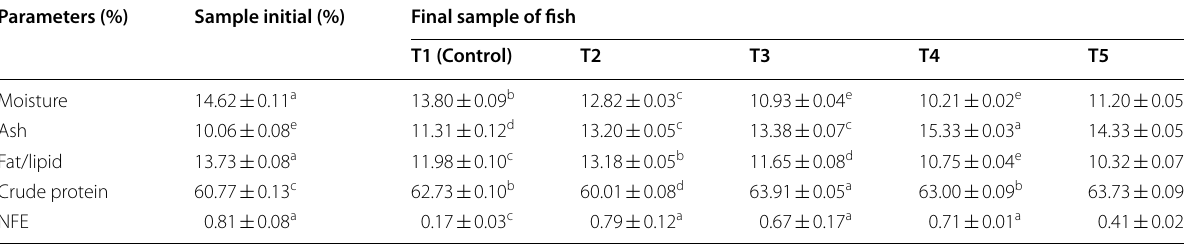
Nitrogen free extract (NFE) as calculated as 100 – (crude protein Figures in each column having the same superscripts are not significantly different ( P > 0.05) Mean in a given row with the same letter a, b, c, d or e were not significantly different at ( P >